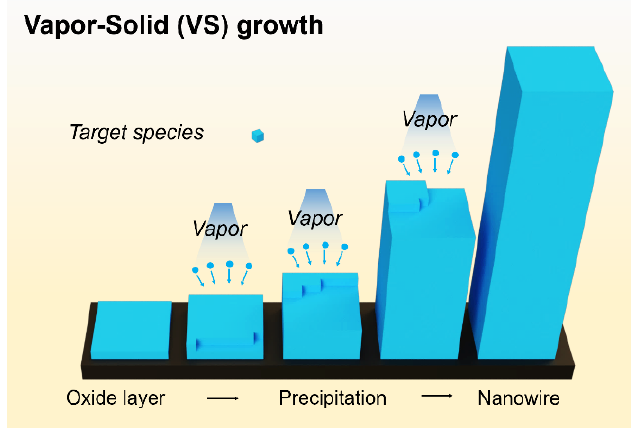
Figure 4. A typical Vapor–Solid (VS) growth mechanism in nanowire fabrication. Compared with VLS growth, VS growth nanowires are suffering from insufficient